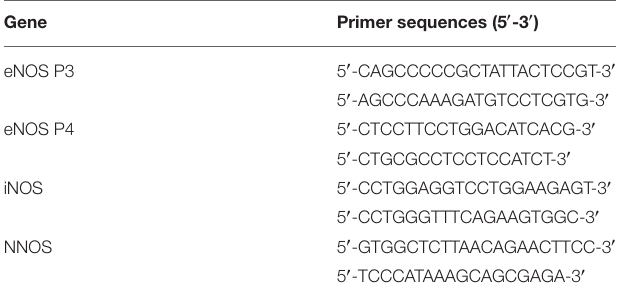
TABLE 1 | Specific amplification primers of NOS 1–3 mRNA genes.